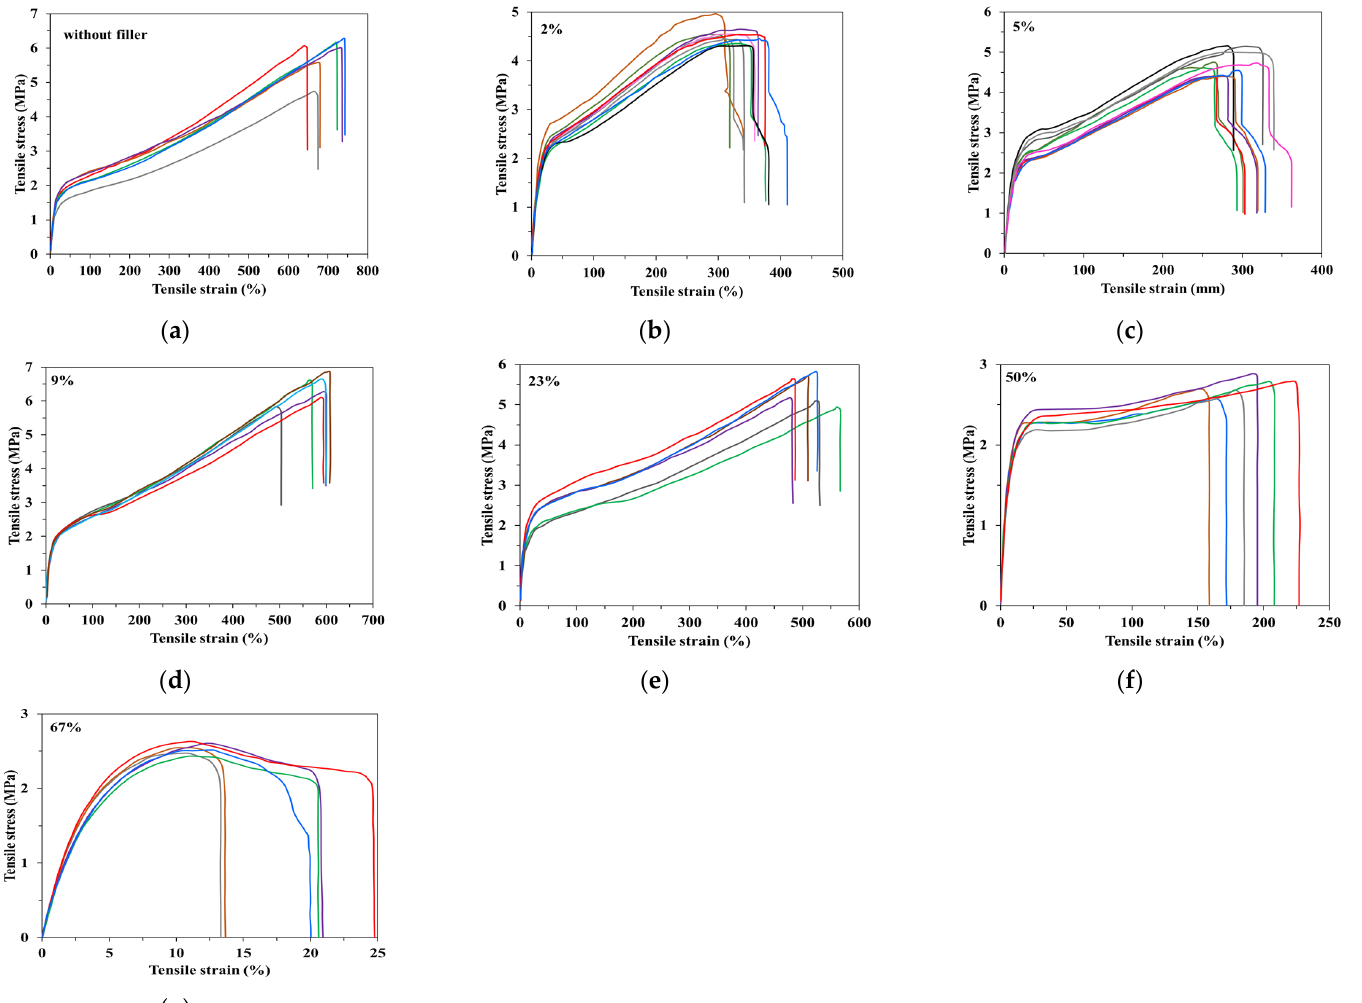
Figure 5. Influence of the CaCO 3 concentration on the stress–strain dependence of binary and ternary starch-based blends ( a )without filler; ( b ) 2%; ( c ) 5%; ( d )